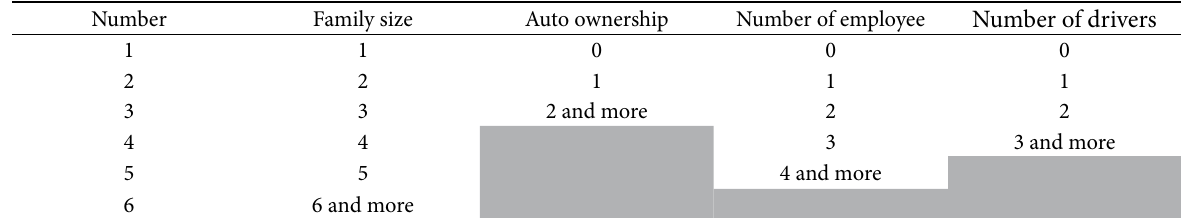
Table 1. The method of categorizing household socio-economic characteristics Number Family size Auto ownership Number of